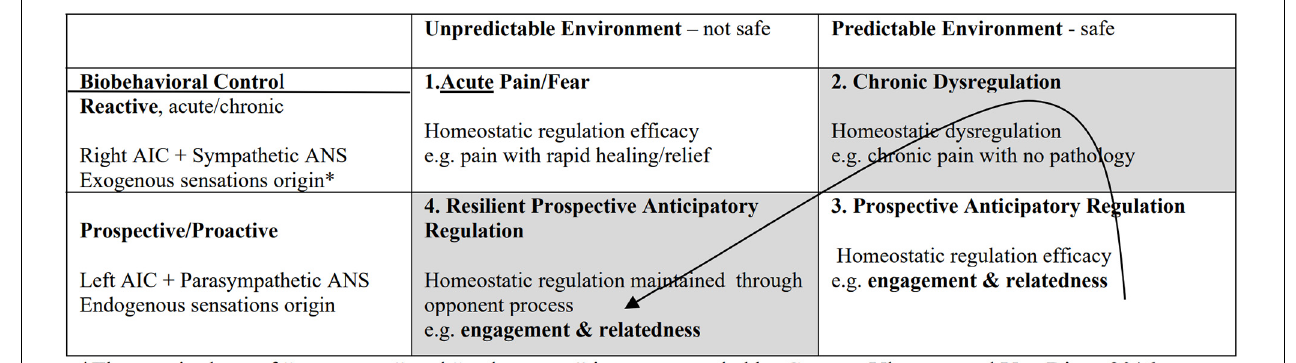
FIGURE 1 | Environment × Biobehavioral Control in